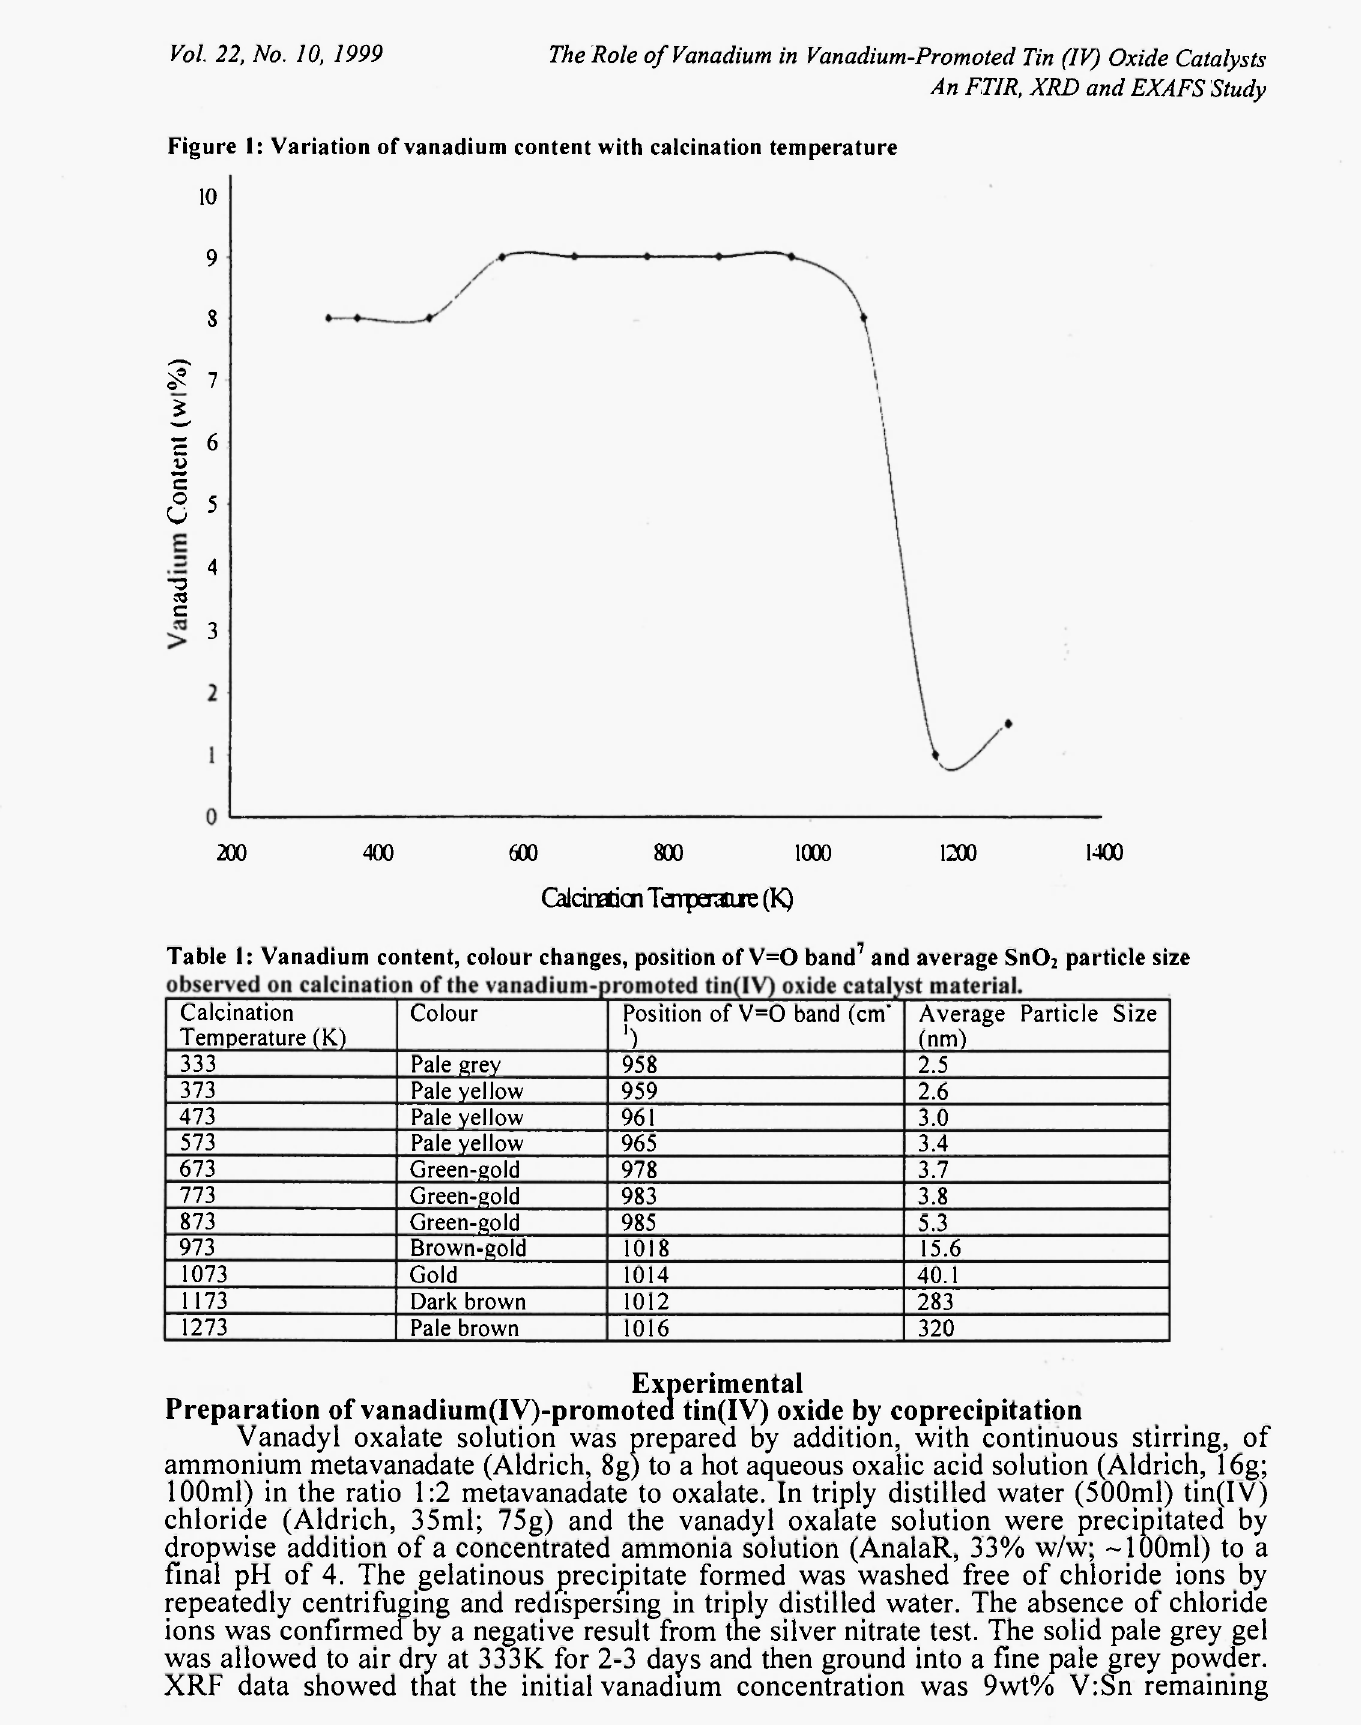
Figure 1: Variation of vanadium content with calcination temperature